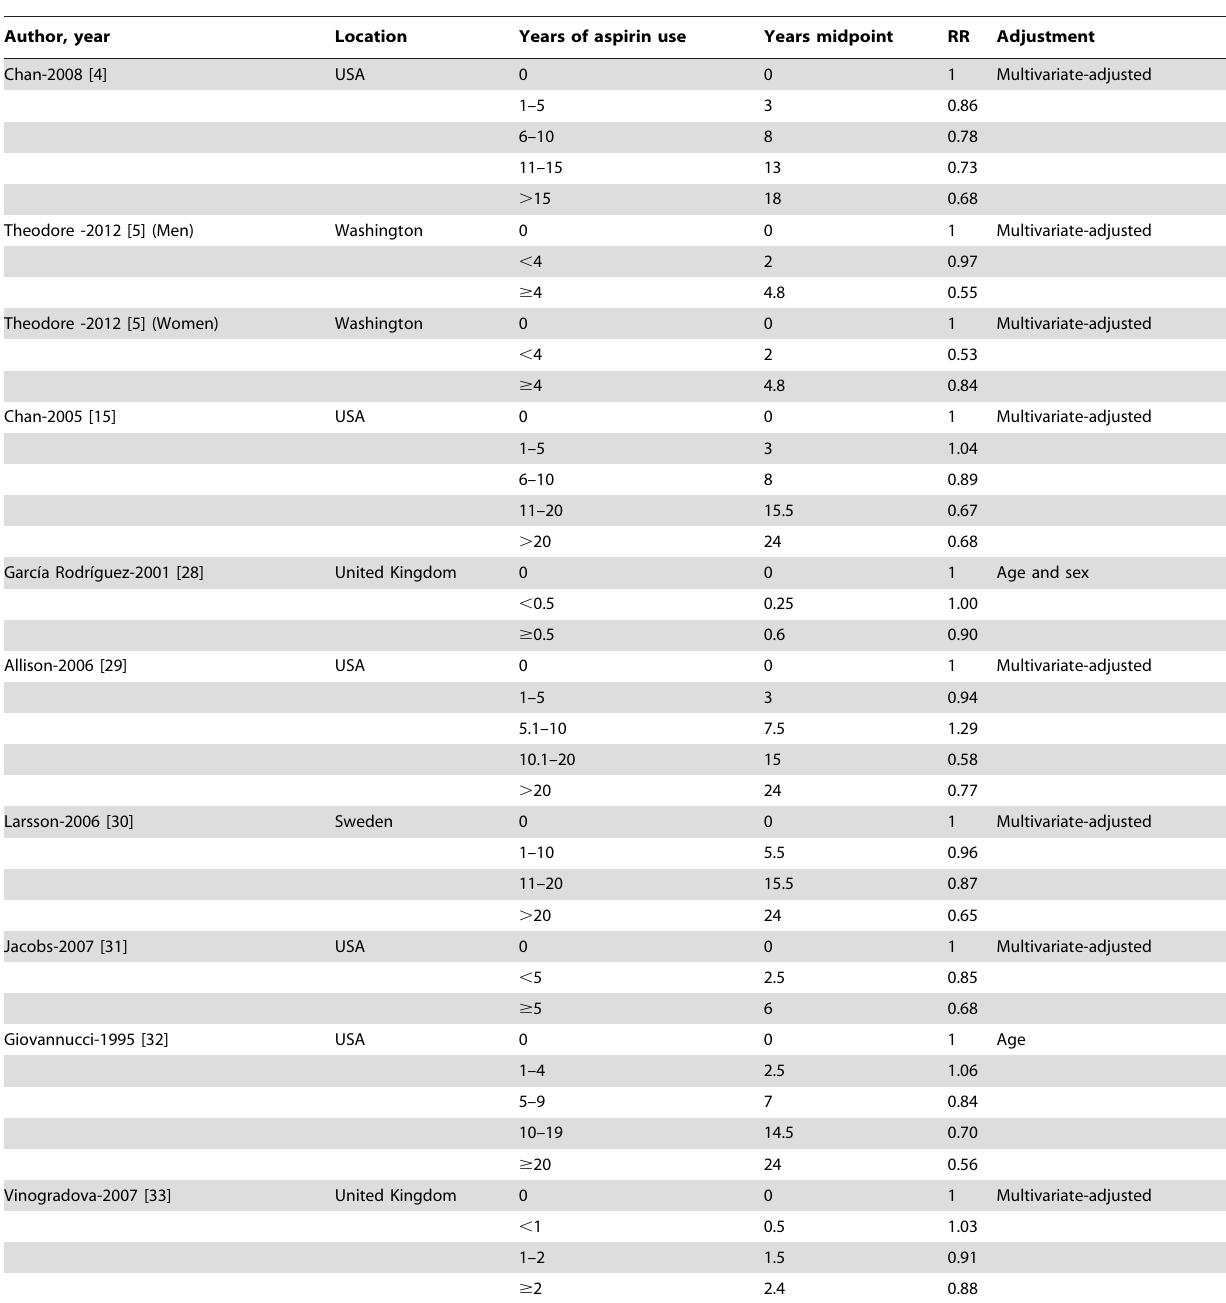
Table 3. Epidemiological studies of years of aspirin use and colorectal